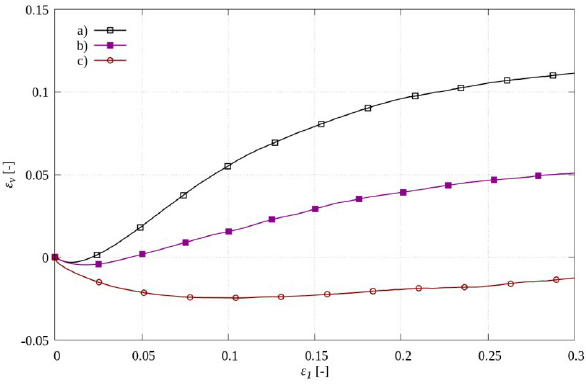
versus vertical normal strain ε from v 1 : a) e = 0.53, b) e = 0.60 and c) e = 0 0 0 0